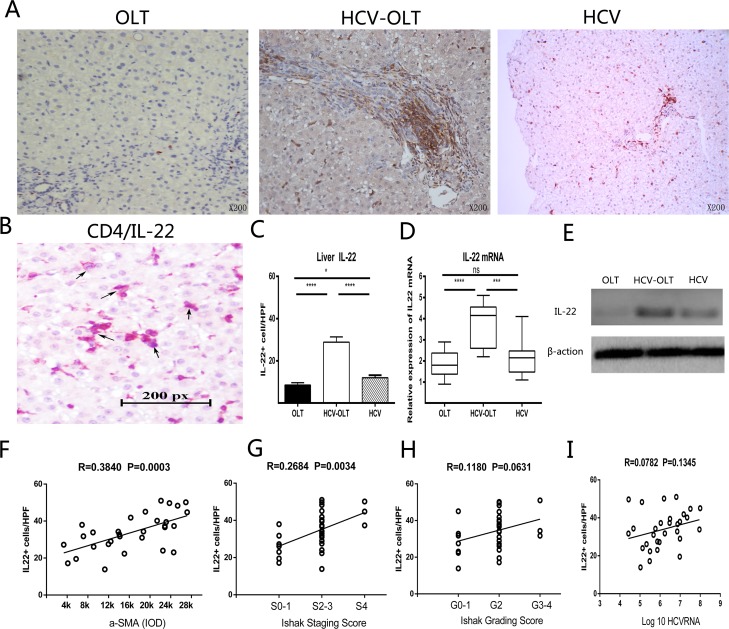
Distribution, expression and correlation of IL-22 cells with liver fibrosis in the liver.(A) IL-22 positive cells mainly located in portal areas with brownish-yellow color by immunohistochemistry. (B) Immunohistochemistry double staining identities IL-22 cells were produced by CD4 cells in liver tissue. Black arrows indicate double-positive cells. The frequencies of IL-22 cells (C) and the expression of IL-22 mRNA (D) in the liver tissue were significantly higher in HCV-OLT patients, compared to the OLT and HCV patients. (E) Protein in the liver also had the same change by Western-blotting. IL-22 cells are positively correlated with α-SMA (F) and fibrosis staging (G), not with grading score (H) and HCVRNA (I). *P < 0.05, **P < 0.01, ***P < 0.001, **** P < 0.0001, ns p>0.05.